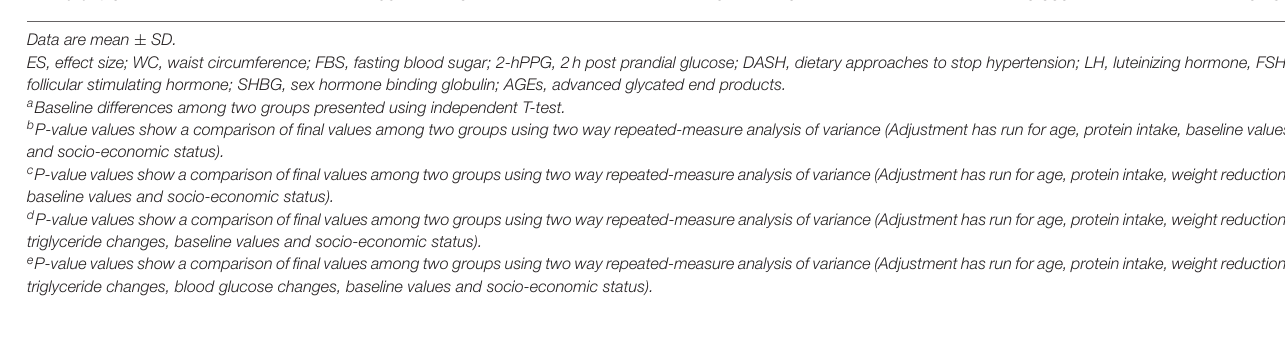
c P-valuevaluesshowacomparisonoffinalvaluesamongtwogroupsusingtwowayrepeated-measureanalysisofvariance(Adjustmenthasrunforage,proteinintake,weightreduction, baseline values and socio-economic status). d P-valuevaluesshowacomparisonoffinalvaluesamongtwogroupsusingtwowayrepeated-measureanalysisofvariance(Adjustmenthasrunforage,proteinintake,weightreduction, triglyceride changes, baseline values and socio-economic status). e P-valuevaluesshowacomparisonoffinalvaluesamongtwogroupsusingtwowayrepeated-measureanalysisofvariance(Adjustmenthasrunforage,proteinintake,weightreduction, triglyceride changes, blood glucose changes, baseline values and socio-economic